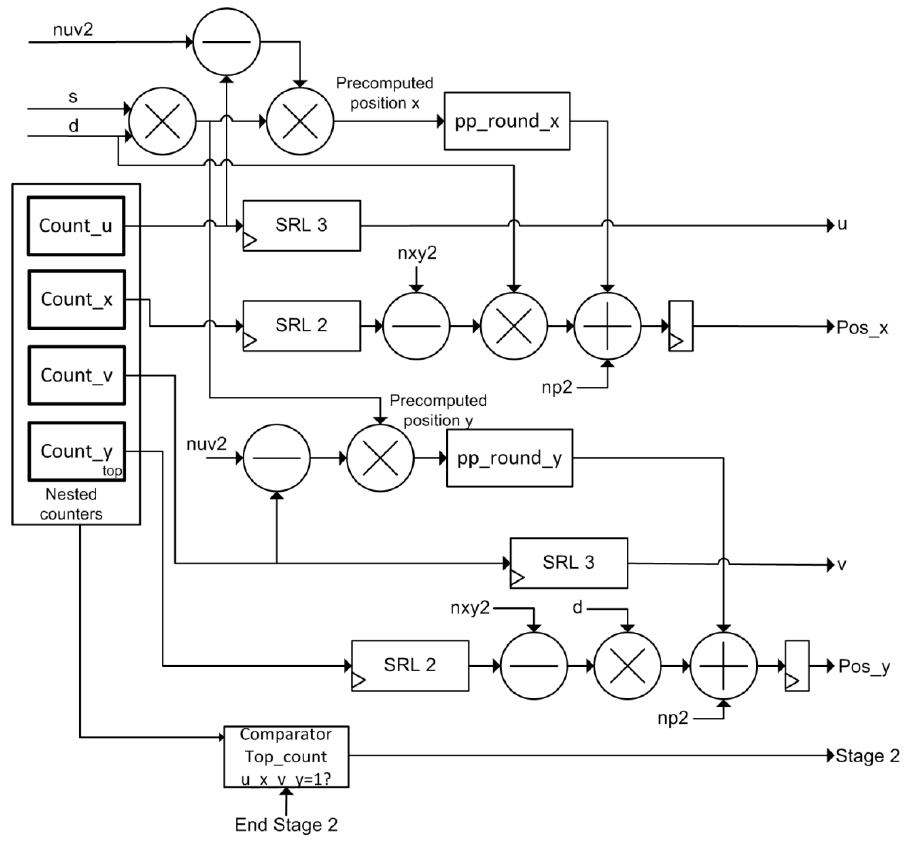
Figure 4. Diagram of the positions estimator